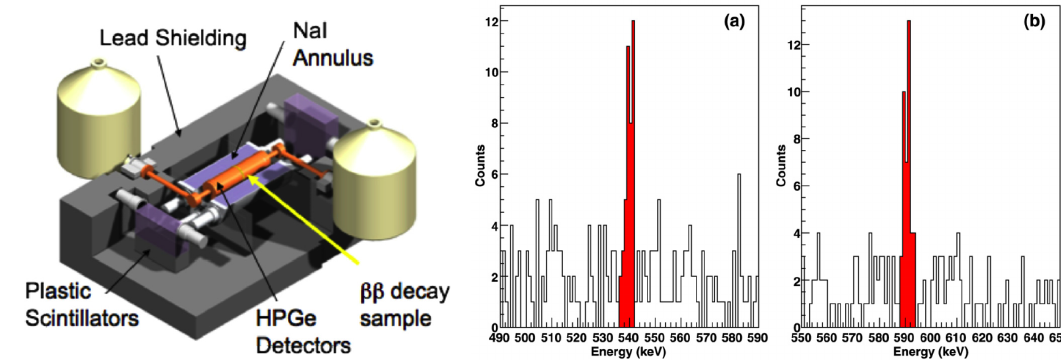
Figure 3. ( left ) Scheme of the experimental apparatus used in the TUNL-ITEP experiment (reprinted from Reference [31] with permission from American Physical Society). ( right ) Total collected events with the TUNL-ITEP apparatus over 905 days. ( a ) γ ray spectrum of events with energy around 540 keV in coincidence with the 590.8 keV transition in 100 Ru, and ( b ) γ ray spectrum of events with energy around 590 keV in coincidence with the 539.5 keV transition in 100 Ru (reprinted from Reference [27] with permission from Elsevier).